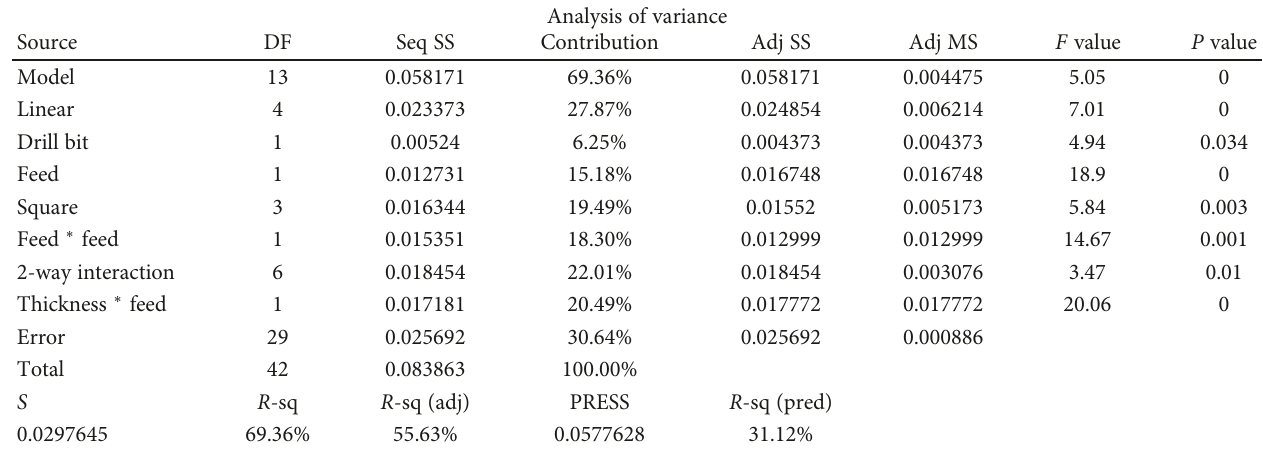
Table 6: ANOVA analysis for delamination